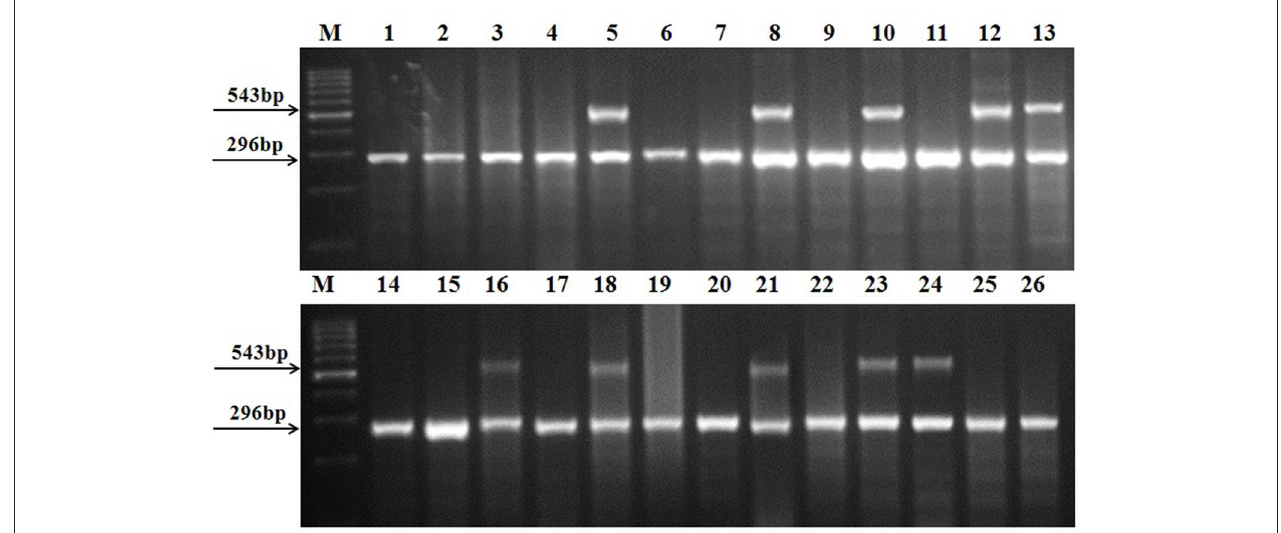
FIGURE 2 | Screening maize landraces from NEHR of India using crtRB1 gene specific marker. (M) Marker (100bp), (1) CAU-M 18, (2) CAU-M 20, (3), CAU-M 1, (4) CAU-M 26, (5) CAU-M 12, (6) CAU-M 21, (7) CAU-M 55, (8) CAU-M 13, (9) CAU-M 31, (10) CAU-M 16, (11) CAU-M 39, (12) CAU-M 17, (13) CAU-M 19, (14) CAU-M 25, (15) CAU-M 2, (16) CAU-M 60, (17) CAU-M 3, (18) CAU-M 66, (19) CAU-M 52, (20) CAU M 36, (21) CAU-M 28, (22) CAU M 24, (23) CAU-M 53, (24) CAU M 138, (25) CAU-M 65, (26) CAU-M